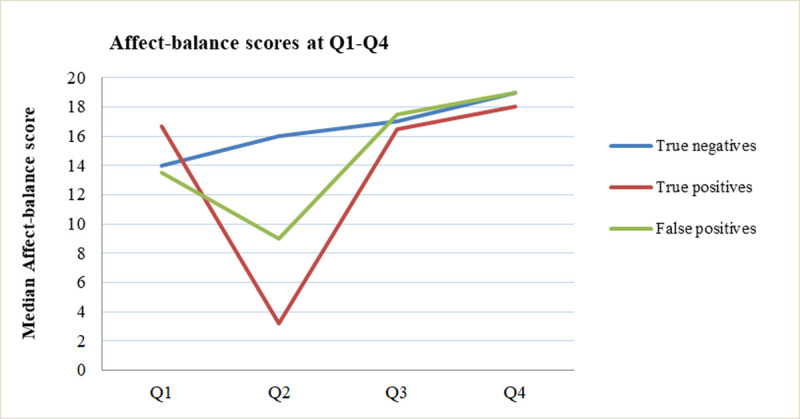
Median affect-balance scores before and after the 13-week and 20-week scans for true-negatives, true-positives and false-positives.